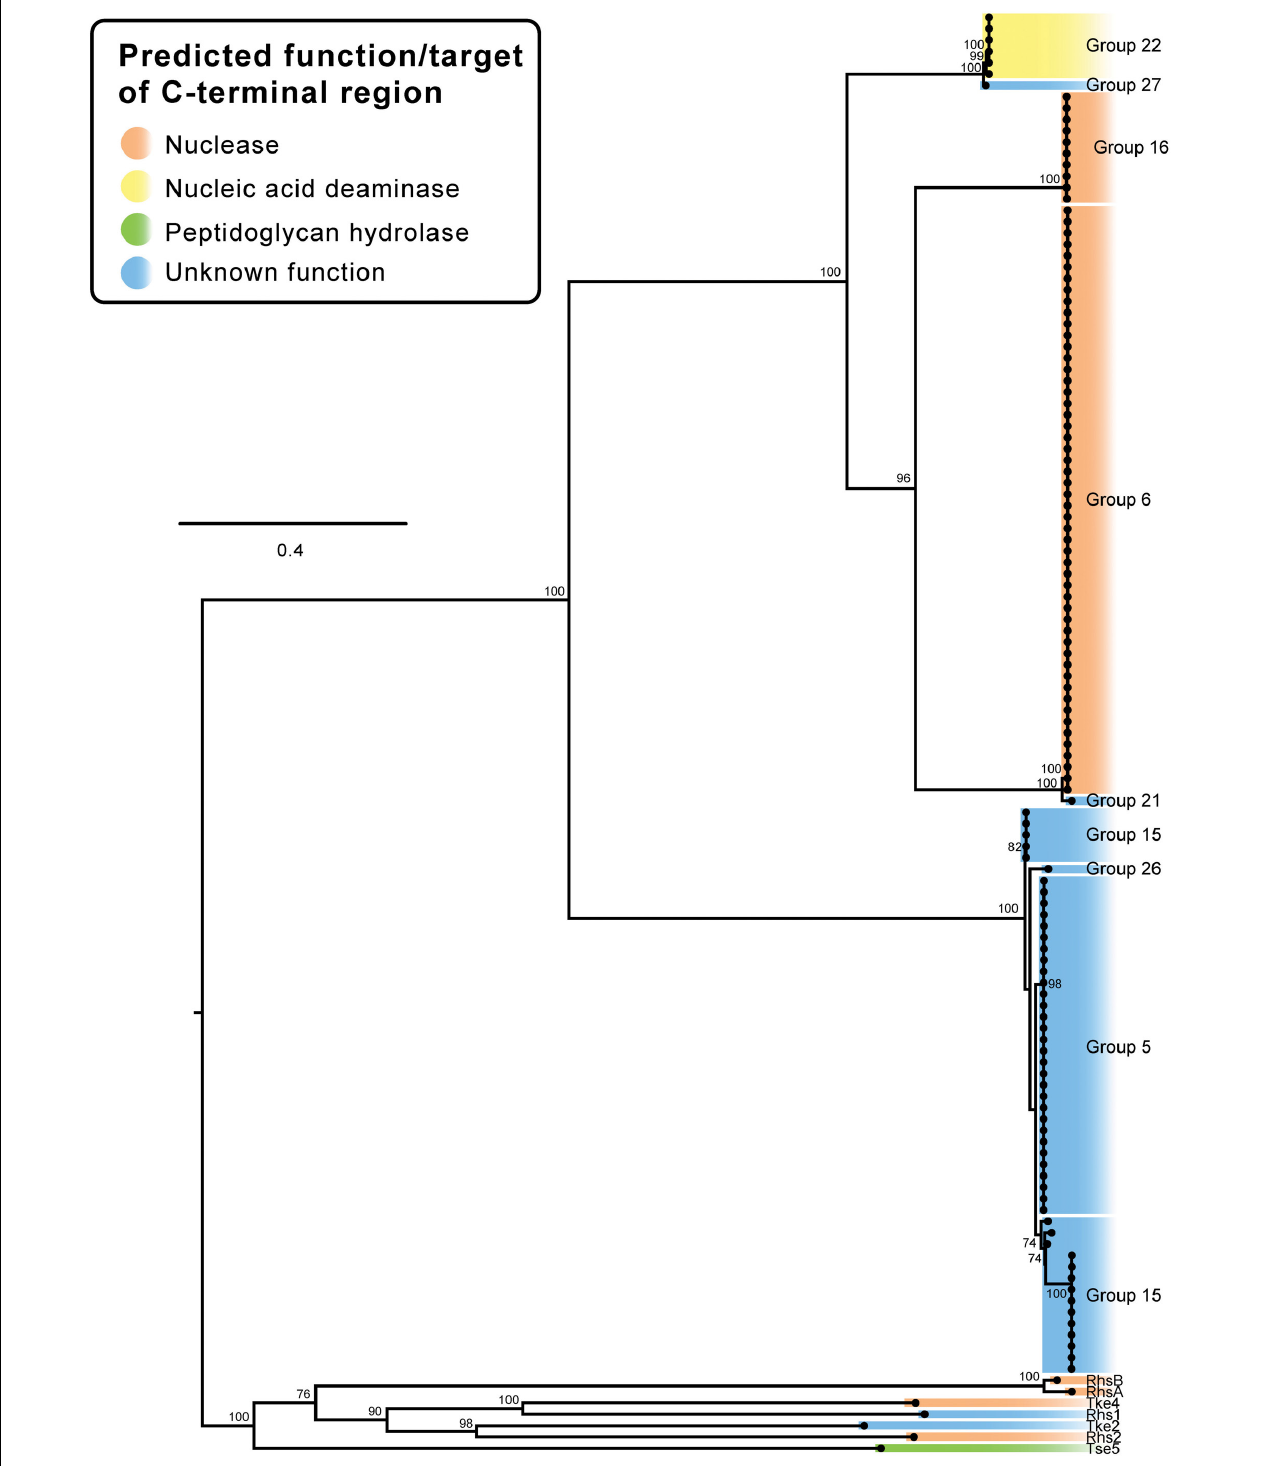
FIGURE 6 | Pre-cleavage region of RHS effectors. ML phylogenetic tree showing the relationship between each of the RHS domain regions from all RHS-family A. baumannii effectors. Comparison excludes the C-terminal region encoding the effector (i.e., only the pre-cleavage amino acid sequences were used). Branches have been named according to the corresponding C-terminal effector group. Tree was generated from amino acid sequences using the general ‘variable time’ matrix with discrete Gamma model (VT + F + I + G4). The scale bar represents the number of amino acid substitutions. Branch support values ≥ 70 (UFBoot) are shown at all major nodes ( Supplementary Files S3c , S4c